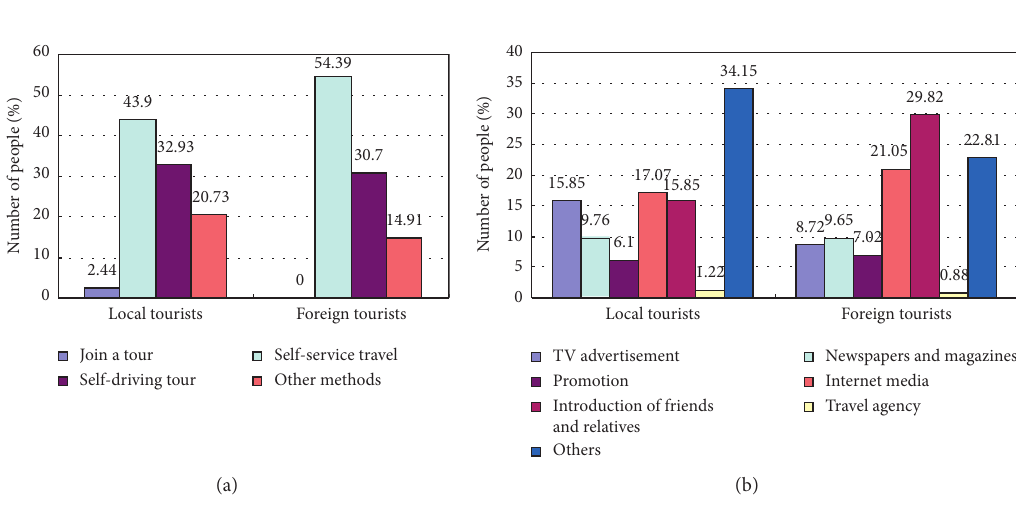
Figure 6: Characteristic analysis of tourist travel behaviour: (a) way of travel; (b) understanding channels.